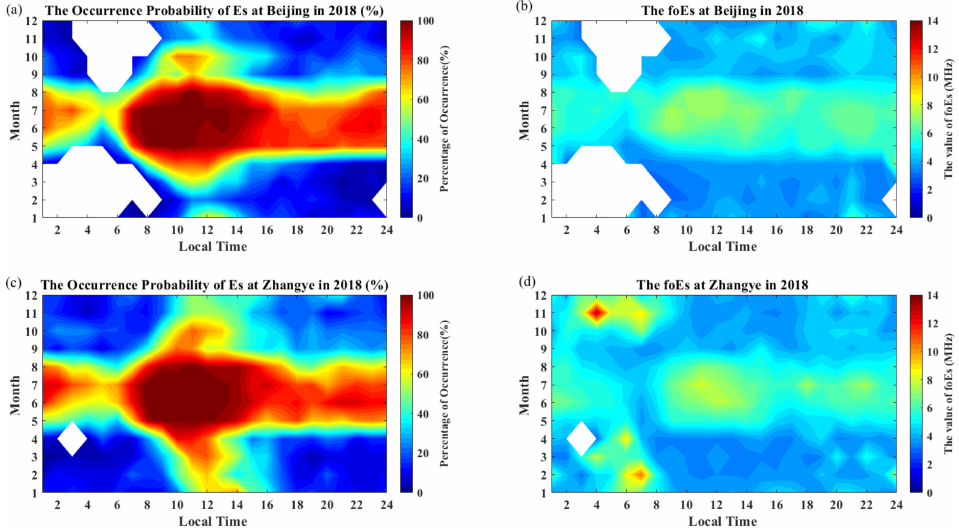
Figure 9. Variations in the occurrence probability and foEs of the Es layer as a function of local time and month at Beijing ( a , b ) and Zhangye ( c , d )